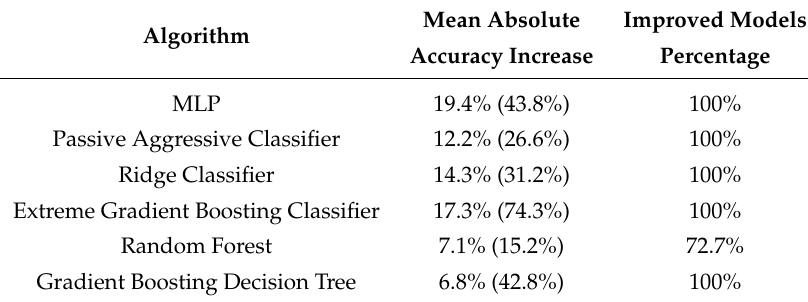
Table 2. Average performances of the models from each algorithm.